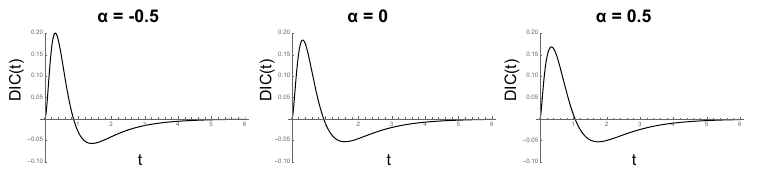
Figure A1. Estimated DIC ( t ) s simulated from a 1-direction serial exhaustive system having FGM cdf with different α values. A L = 3, A H = 12, B L = 1, B H =